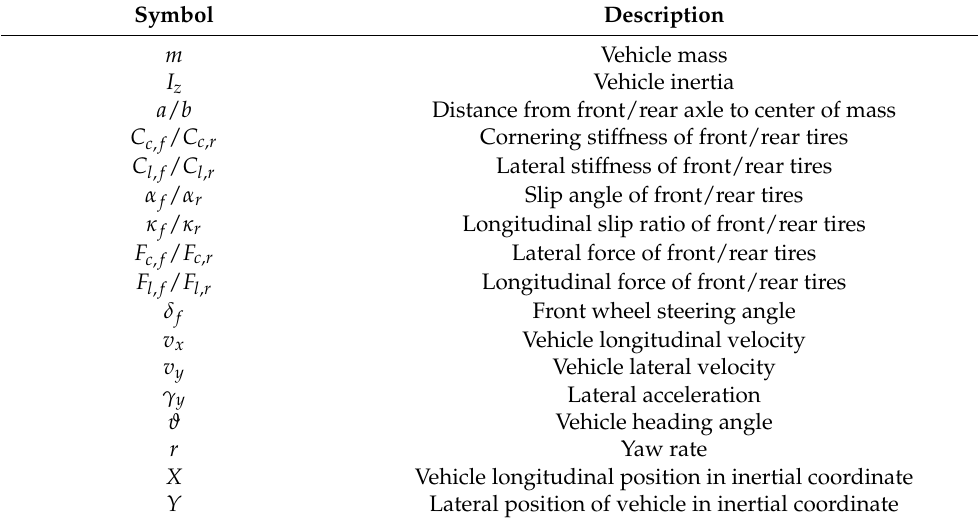
Table 1. Vehicle model parameters.